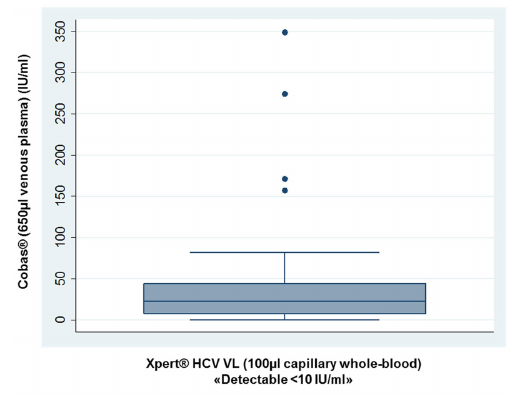
Figure 2: Xpert ® HCV Viral Load (VL) test: Cobas ® results (ve- nous plasma) for the 31 capillary HCV RNA measurements below the limit of quantification of 10 IU/ml (1.0 log IU/ml).For unquantifi- able positive Cobas ® results (“detectable below the limit of